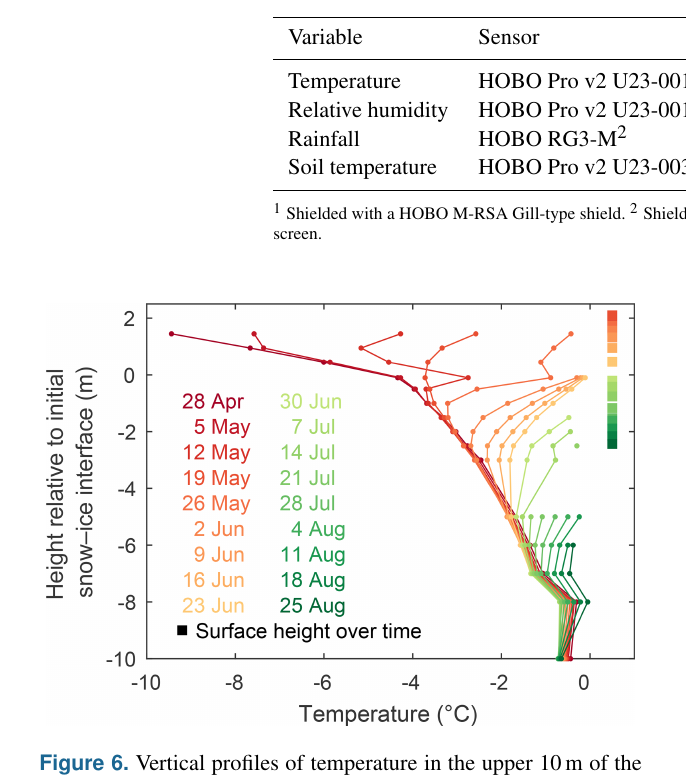
Table 3. Sensors used for the simple glacier and tundra weather stations. Glacier stations included only temperature and relative humidity while tundra stations also included precipitation and soil temperature measurements.